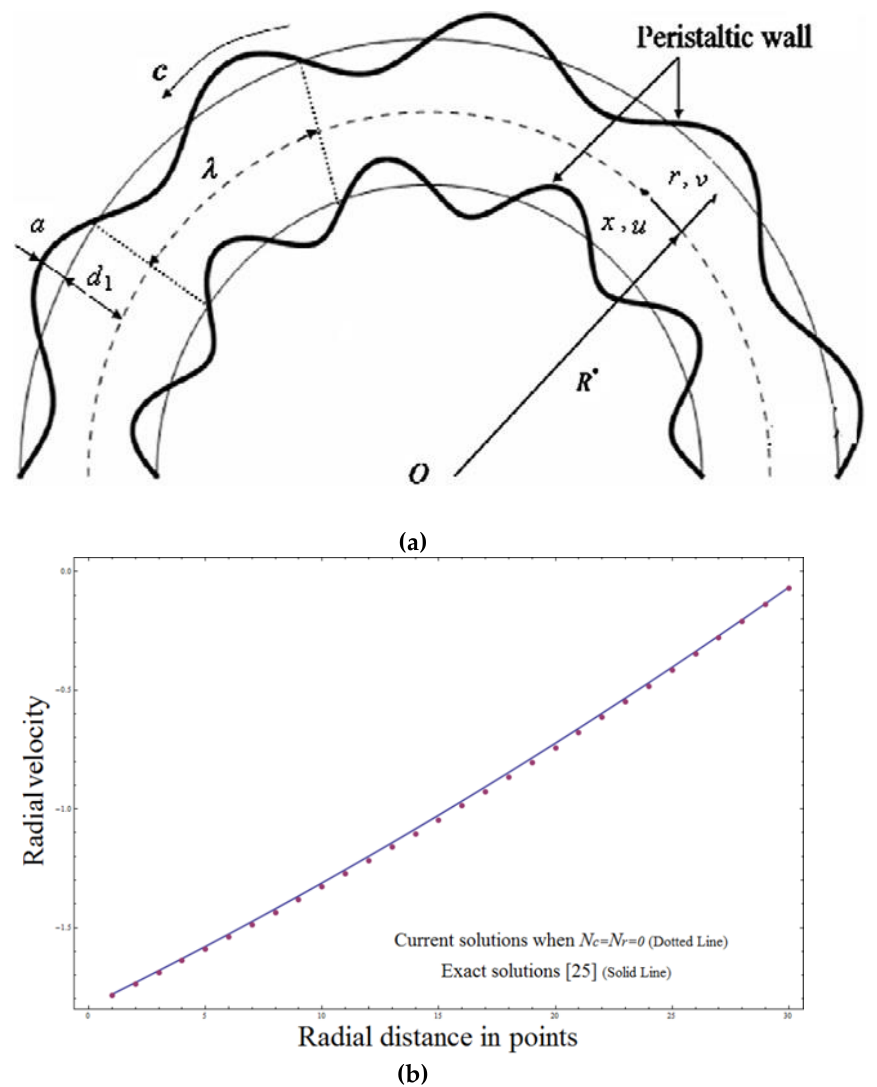
Figure 1. ( a ) Geometry of the problem. ( b ) Comparison of current work with literature [25].